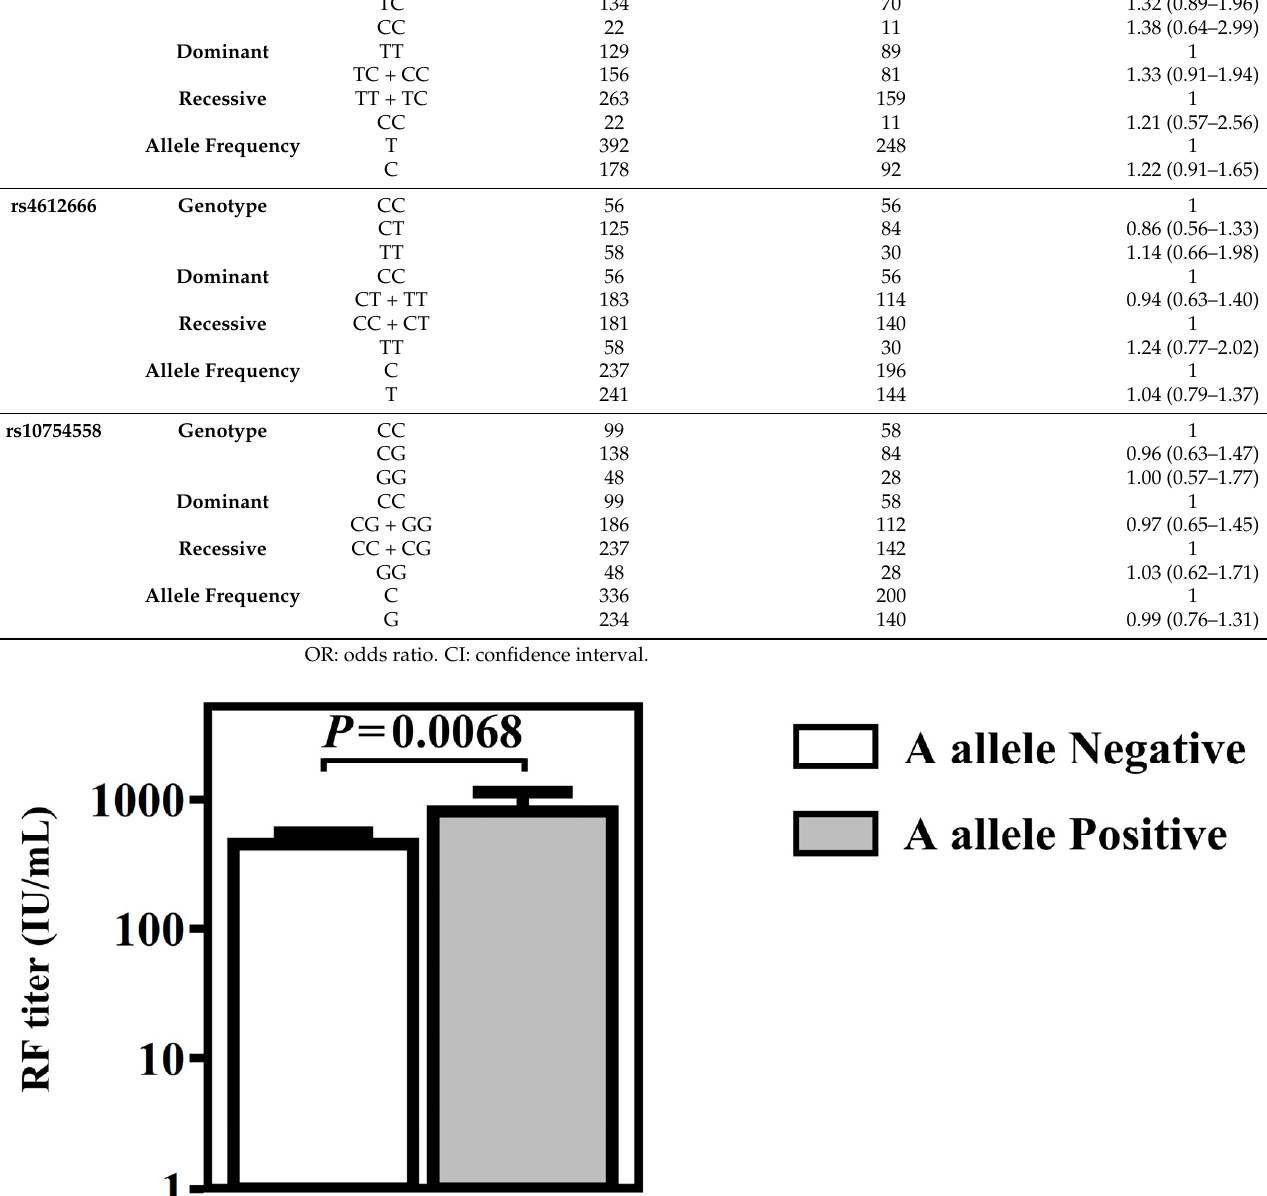
Table 4. Associations of alleles of NLRP3 genotype with anti-CCP antibody in primary Sjogren’s syndrome patients.